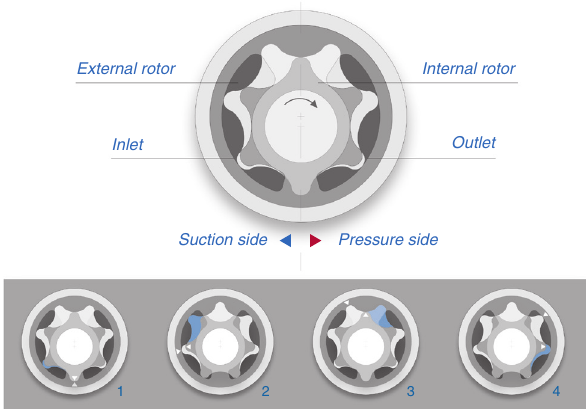
Figure 1 Operation principle of micro annular gear pumps.